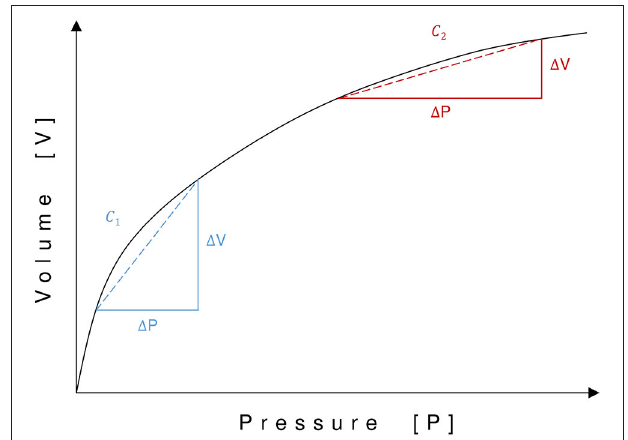
(P) is displayed on the x-axis and volume (V) on the y-axis. Compliance ( C ) is represented by the slope of the pressure–volume curve. Due to its exponential function, compliance varies with different pressure–volume status. A shift to the left on the pressure–volume curve leads to increased compliance ( C 1), whereas a shift to the right leads to decreased compliance ( C 2).